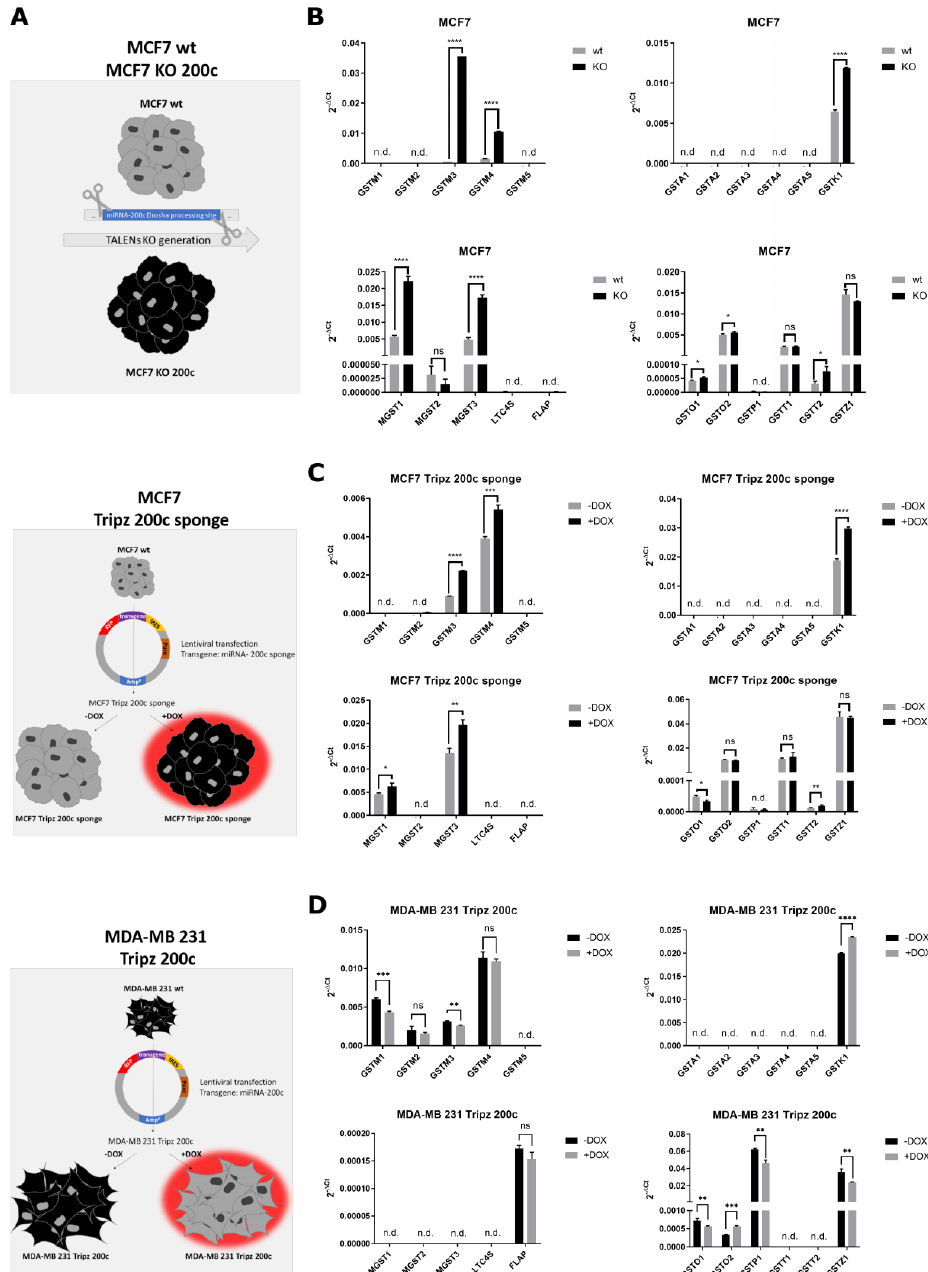
Figure 3. Expression of glutathione S-transferases (GSTs) in different hsa-miR-200c expression systems. ( A ) Overview of the generation of cell systems. Corresponding qRT-PCR analysis of all glutathione S-transferases in the ( B ) MCF7 wildtype and MCF7 KO 200c, ( C ) MCF7 Tripz 200c sponge and ( D ) MDA-MB 231 Tripz 200c cell line. Both Tripz construct systems were induced (or not) with 5 µ g/mL doxycycline (DOX) for 72 h. An unpaired two-tailed Student’s t -test was performed. * p < 0.05, ** p < 0.01, *** p < 0.001, **** p < 0.0001. Values are displayed as mean with SD. ns = not significant, n.d. = not detected .